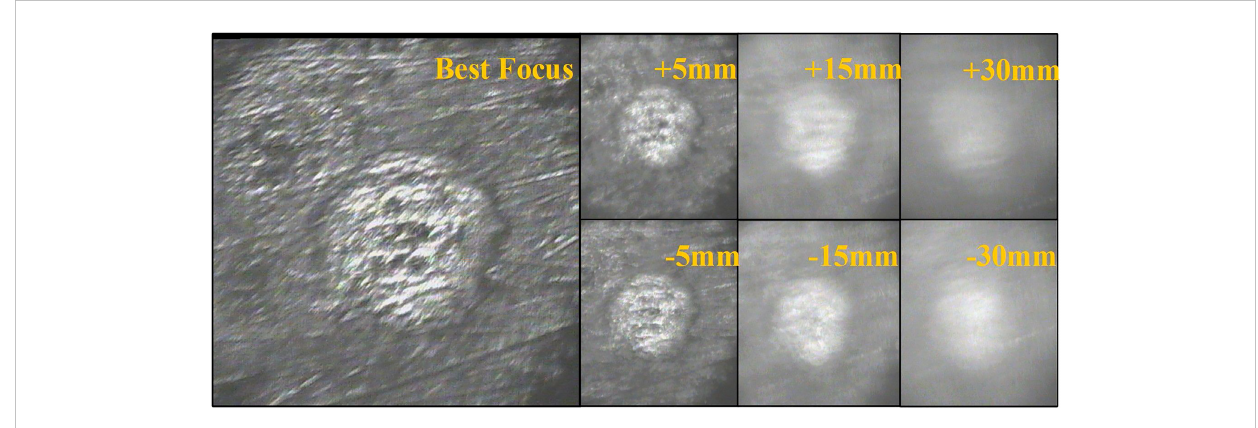
FIGURE 6 Focus photo and defocus photos by CCD.